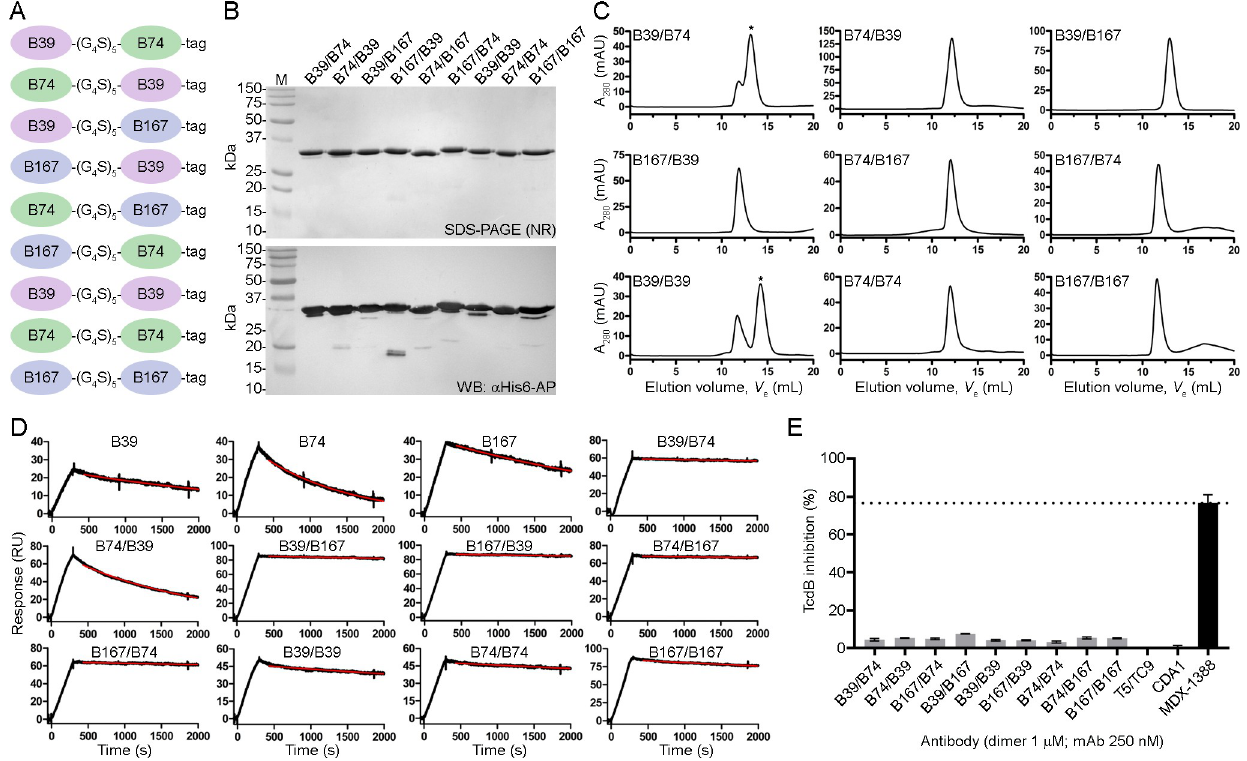
Fig 3. Generation and characterization of V H H-V H H dimers. (A) Cartoon diagram of V H H-V H H dimers separated by a 25 amino acid linker (G 4 S) 5 and containing a C-terminal His 6 “tag”. (B) Dimers were expressed, purified and analyzed by non-reducing (NR) SDS-PAGE and probed by α -His 6 -AP in Western blot (WB). M, protein molecular mass marker. (C) SEC profiles of dimers. Asterisks denote the peaks that were selected for SPR analysis when aggregates were present. (D) SPR sensorgrams showing dissociation phases of V H H-V H Hs and parent monomers. (E) TcdB neutralization with V H H-V H H dimers. The final TcdB concentration of 3–10 pM and V H H-V H H concentration of 1 μ M was co-incubated with Vero cell monolayers for 72 h before addition of WST-1 cytotoxicity reagent. MDX-1388 was used at 250 nM. Neutralization values are presented as mean ± SD from n = 3 independent